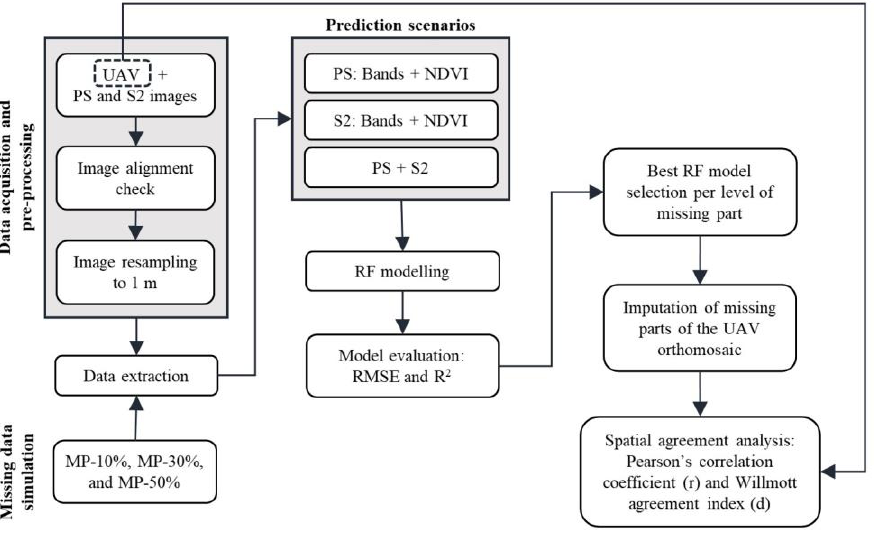
Figure 3. Flowchart for UAV and satellite imagery processing and filling in the missing parts in UAV orthomosaics based on the RF algorithm and ancillary data derived from satellite image.